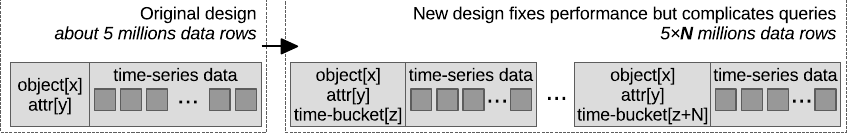
Figure 1. Use of time buckets in row ID to address Cassandra performance